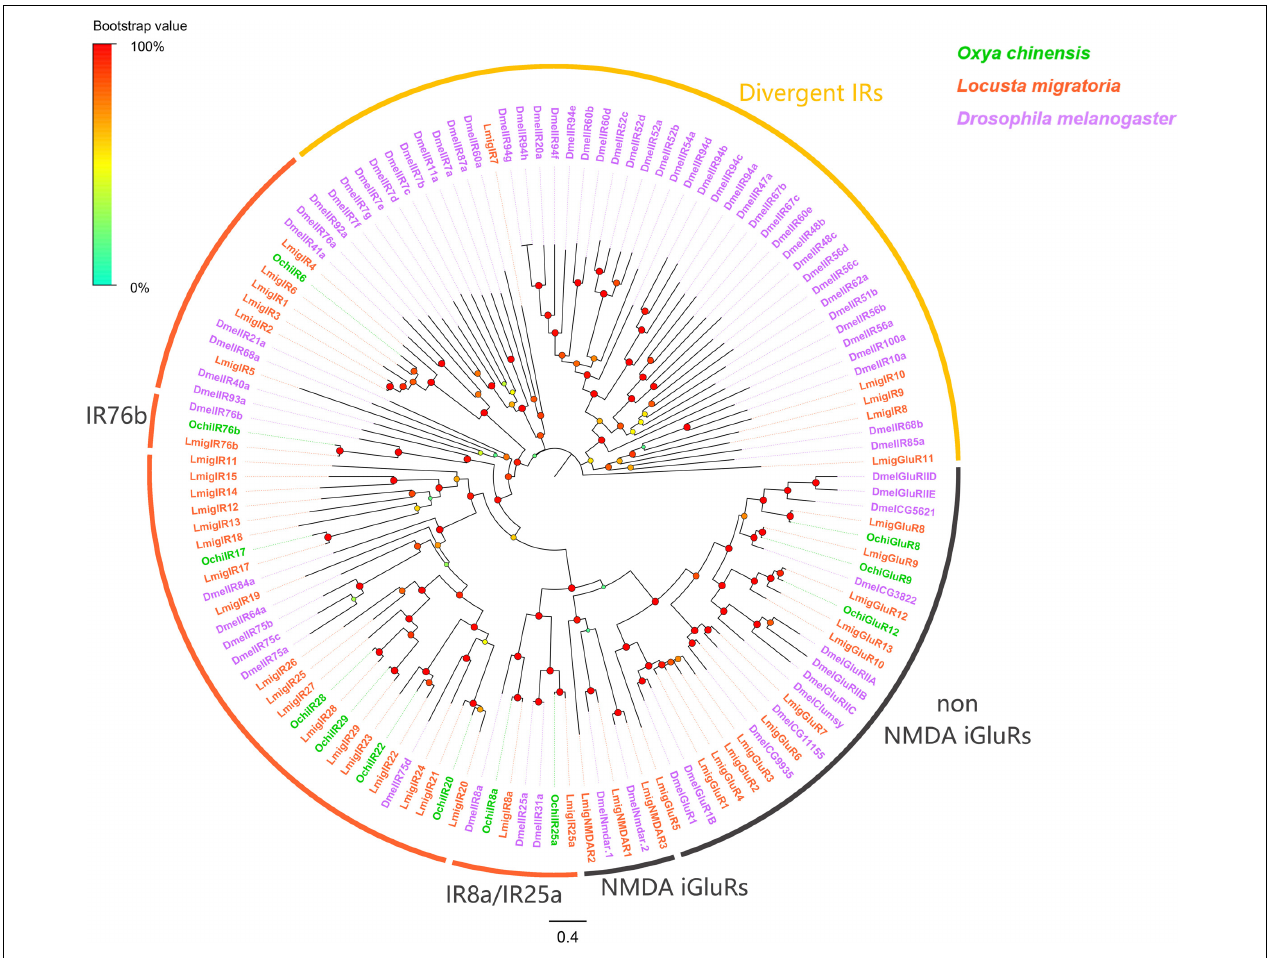
FIGURE 4 | Phylogenetic tree of putative ionotropic receptors (IRs). Branch support (circles at the branch nodes) was estimated using an approximate likelihood ratio test based on the scale indicated at the top left. Bars indicate branch lengths in proportion to amino acid substitutions per site.